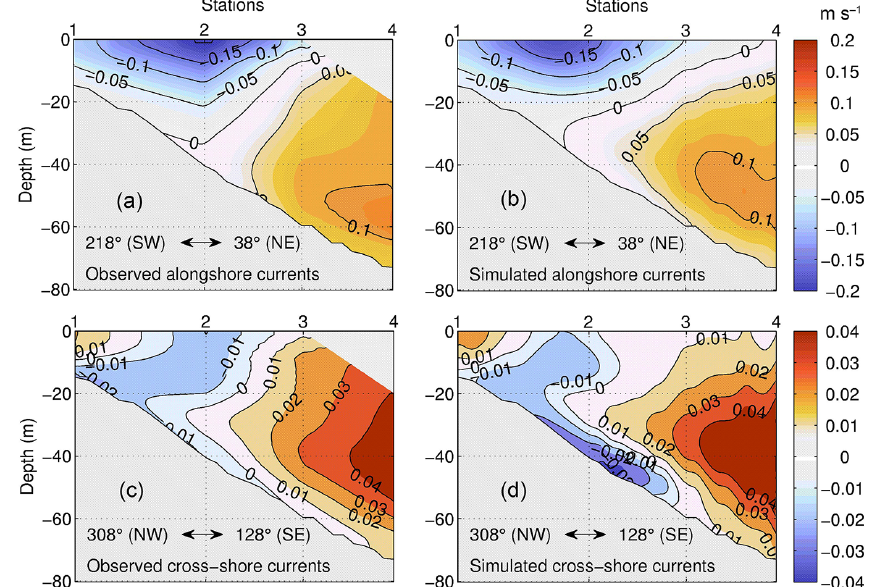
Figure 3. Validations of the wintertime TWC (warm color) along the section off the Zhe-Min coast (the short line with four red numbers in Fig. 2): (a) observed alongshore currents, (b) simulated alongshore currents, (c) observed cross-shore currents and (d) simulated cross-shore currents. Note, an enlarged color scale is used for the cross-shore component to have a clear view of its weak structure.